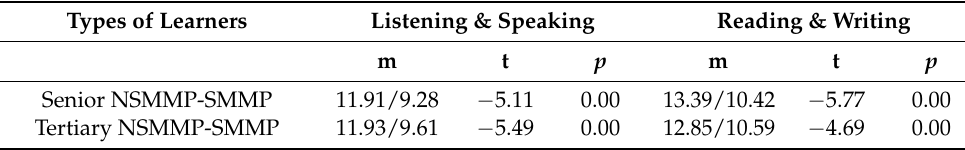
Table 2. Results of learners’ late-stage language abilities.